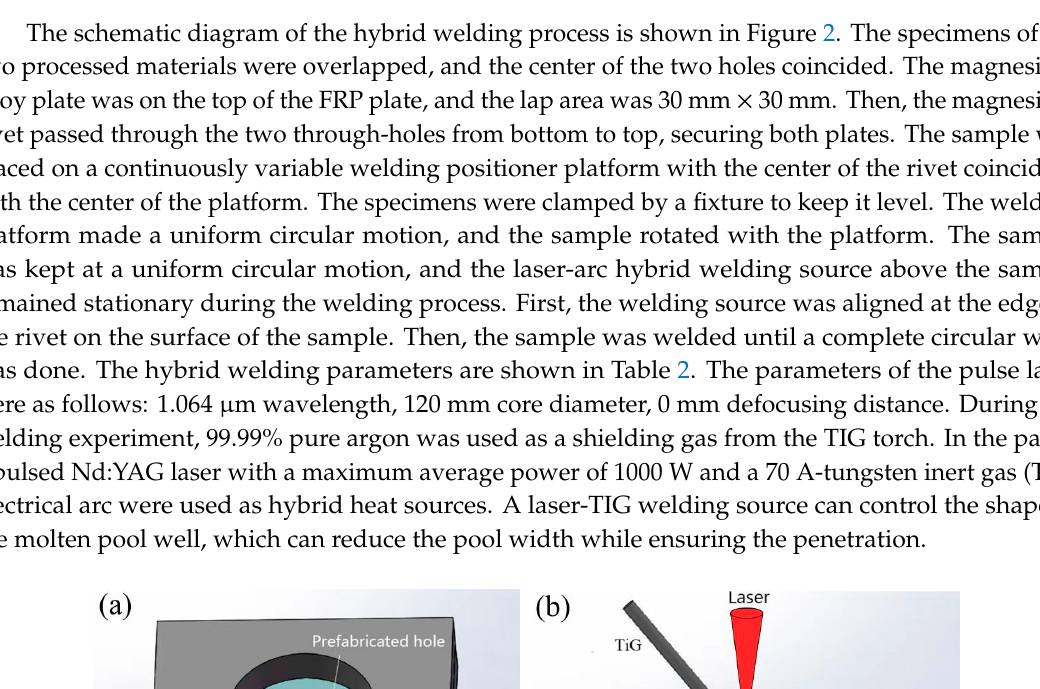
Figure 1. The structure of magnesium step rivet. ( a ) structure of the rivet; ( b ) Mg rivet.